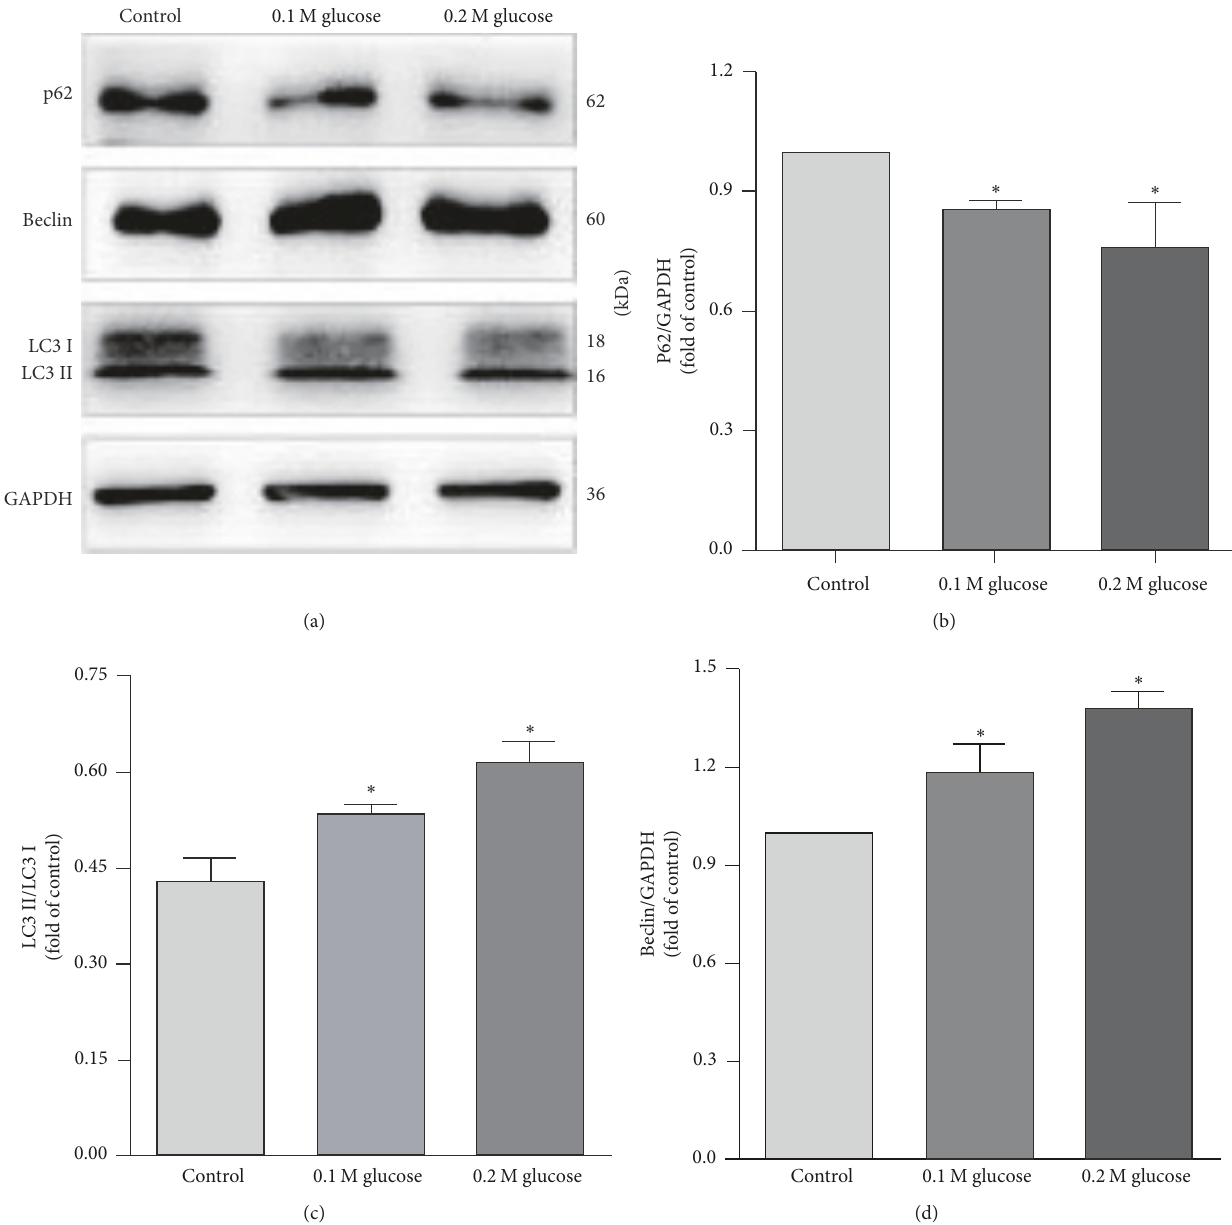
Figure 2: Western blot showed an increased expression of Beclin-1 and LC3-II and a decreased expression of p62 in the NP cells treated with high glucose. ∗ represents a significant difference from the control group (𝑝 < .05)